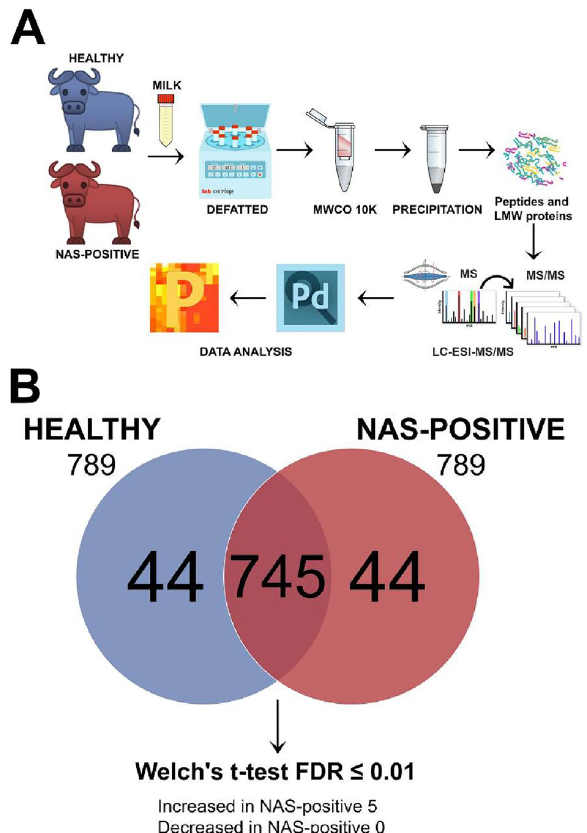
Figure 1. Shotgun label-free quantitative peptidomic analysis. ( A ) Overview of the protocols applied for the analysis of peptides in NAS-positive and healthy milk samples ( B ) Venn diagram of all the peptides identified in milk samples from healthy and NAS-positive buffaloes. Peptides were considered differentially abundant if they were present only in NAS-positiver or Control milk or showed significant Welch t test difference (cut-off at 1% permutation-based False Discovery Rate).